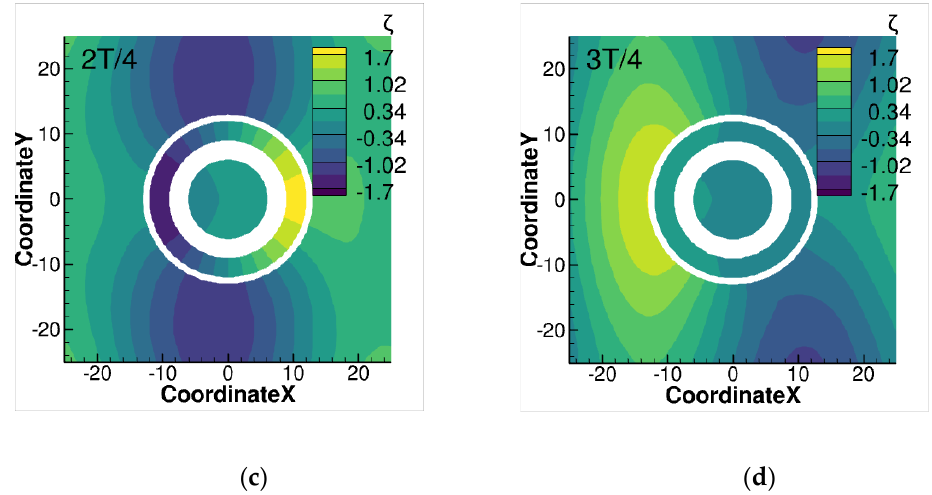
Figure 13. Snapshots of the non ‐ dimensional surface elevation ( ζ /( Η /2)) during a wave period for Configuration 1 and ω = 1.1 rad/s ; ( a ) t = 0T/4; ( b ); t = T/4; ( c ) t = 2T/4; ( d ) t = 3T/4.